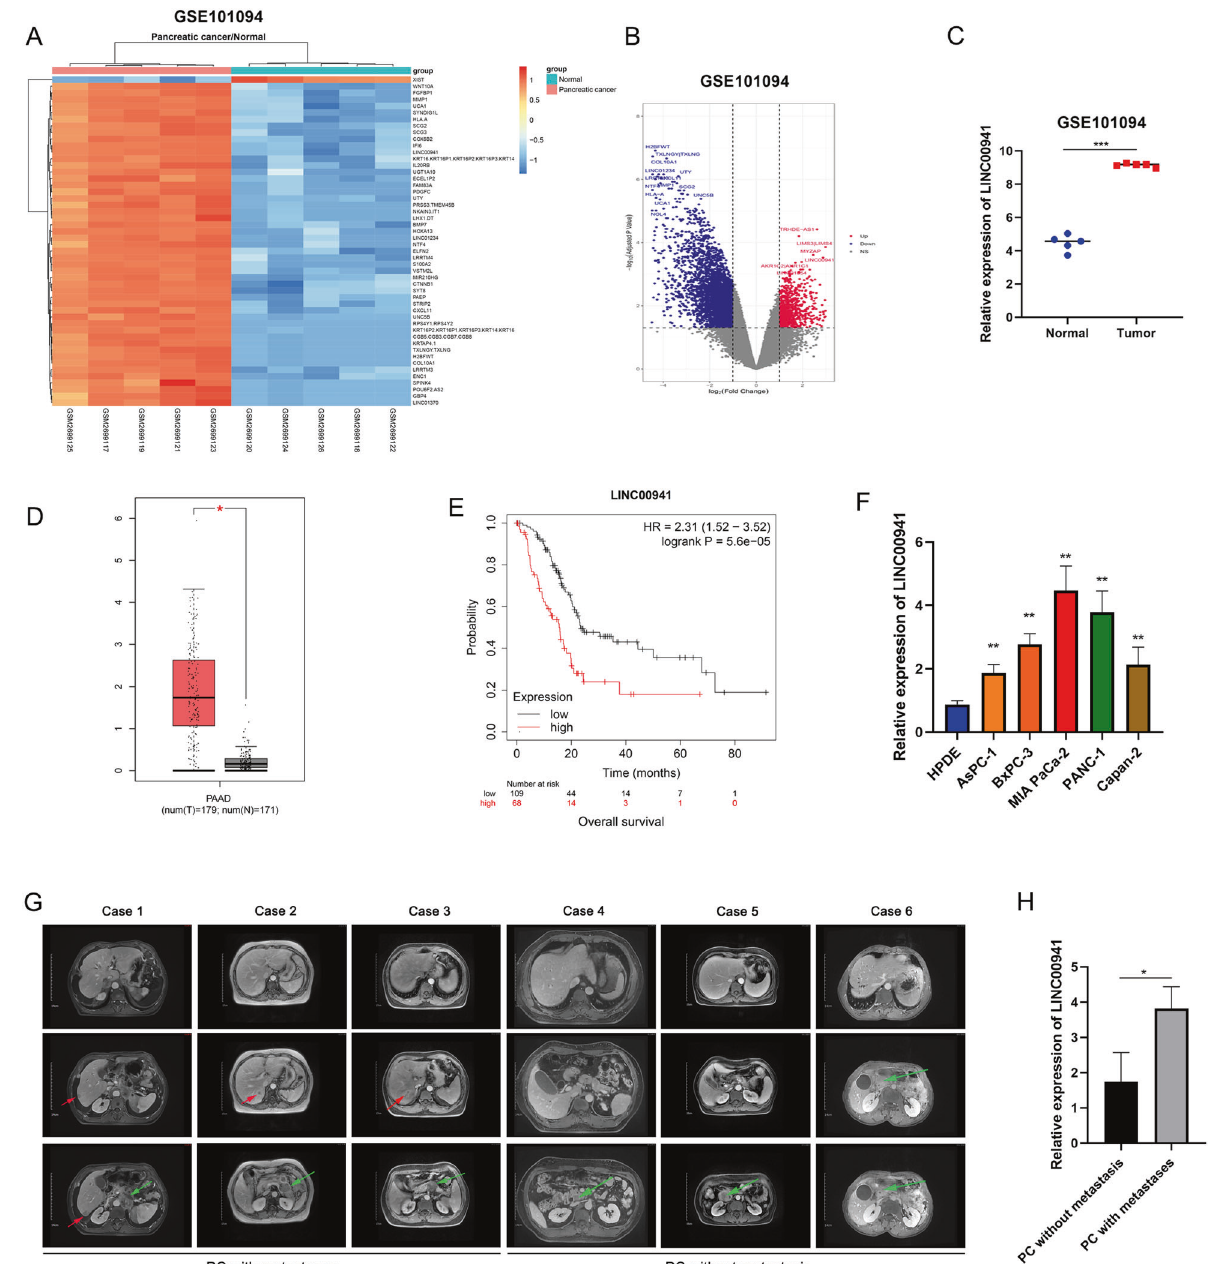
Fig. 1 Screening and identi fi cation of lncRNA in pancreatic cancer. A Heatmap of different RNA at the transcriptional level from fi ve paired pancreatic cancer tissues and adjacent normal tissues based on GEO database (GSE101094). B Volcano plot of differentially expressed genes in GSE101094. C The expression of lncRNA LINC00941 in pancreatic cancer tissues compared to adjacent normal tissues in GSE101094. D The expression of LINC00941 in pancreatic cancer tissues and normal tissues in GEPIA based on TCGA database (tumors tissues:179, normal tissues: 171). E Kaplan – Meier curve was performed to analyze the prognosis of pancreatic cancer patients with high LINC00941 expression compared to low LINC00941 expression. F The expression of LINC00941 in HPDE and fi ve pancreatic cancer cell lines, including AsPC-1, BxPC- 3, MIA PaCa-2, PANC-1, and Capan-2 were validated by qRT-PCR analysis. G The representative MRI images of pancreatic cancer patients with or without isolated liver metastases. Case 1-3 had isolated liver metastases, and Case 4-6 had no liver metastasis. Red arrow points to liver metastases, green arrow points to the primary tumor of the pancreas. H The expression of LINC00941 in pancreatic cancer tissues from patients with metastasis and without metastasis was evaluated by RT-qPCR analysis. *, **, and ***, respectively, represent P < 0.05, P < 0.01, and P < LINC00941 and ANXA2, the results of which con fi rmed their bioinformatics prediction site RNAInter (http://www.rnainter.org/) interaction (Fig. 2A). To identify whether LINC00941 could bind and found that ANXA2 was an LINC00941 -interacting protein proteins, we used RNA pull-down assays followed by mass (Supplementary Fig. 2A). In addition, RNA – Protein Interaction spectrometry (MS) analysis to identify potential interacting Prediction (RPISeq) (http://pridb.gdcb.iastate.edu/RPISeq/) was proteins (Fig. 2B). The results suggested that ANXA2 was an performed to estimate the interaction probabilities between